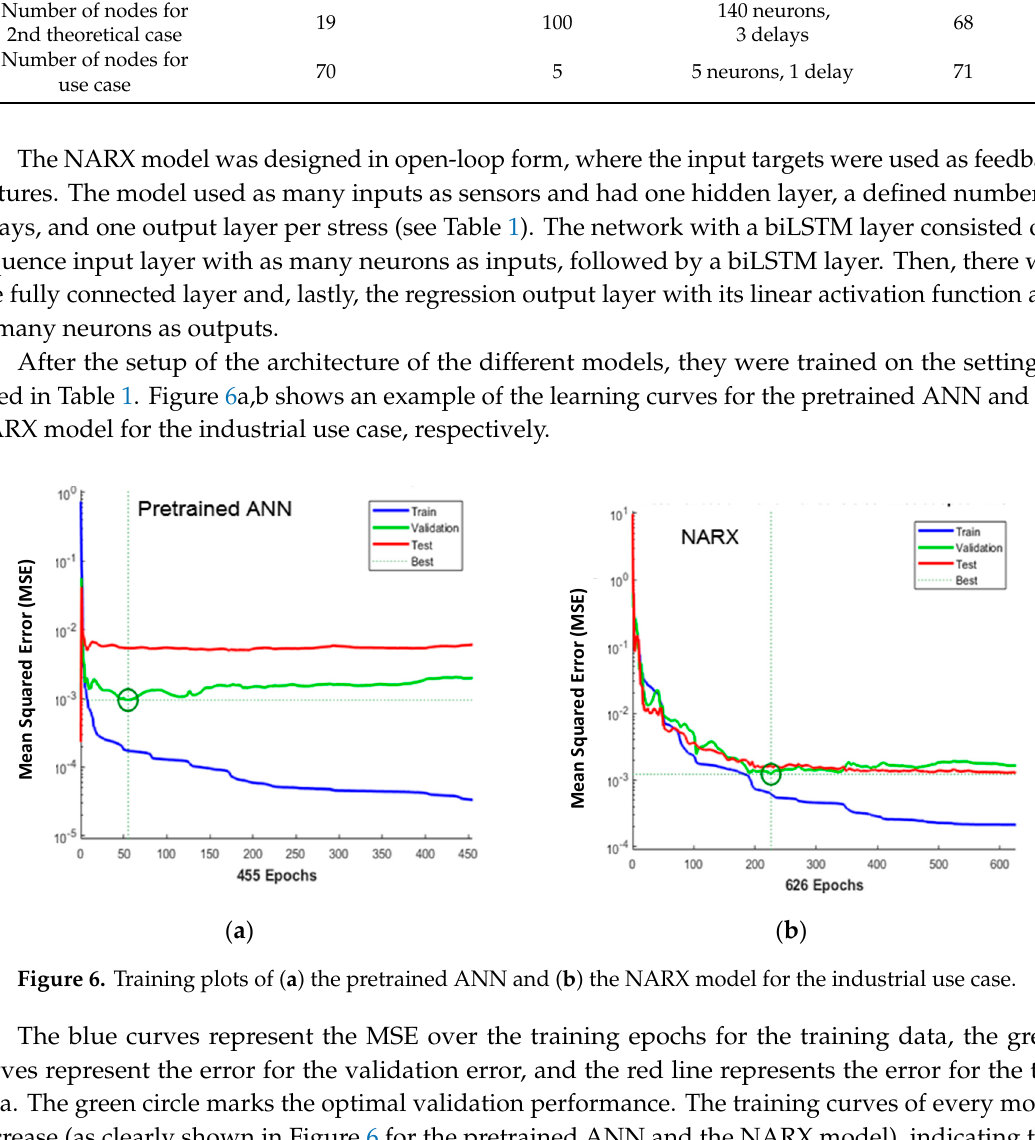
Table 1. Architecture of the di ff erent ANNs.